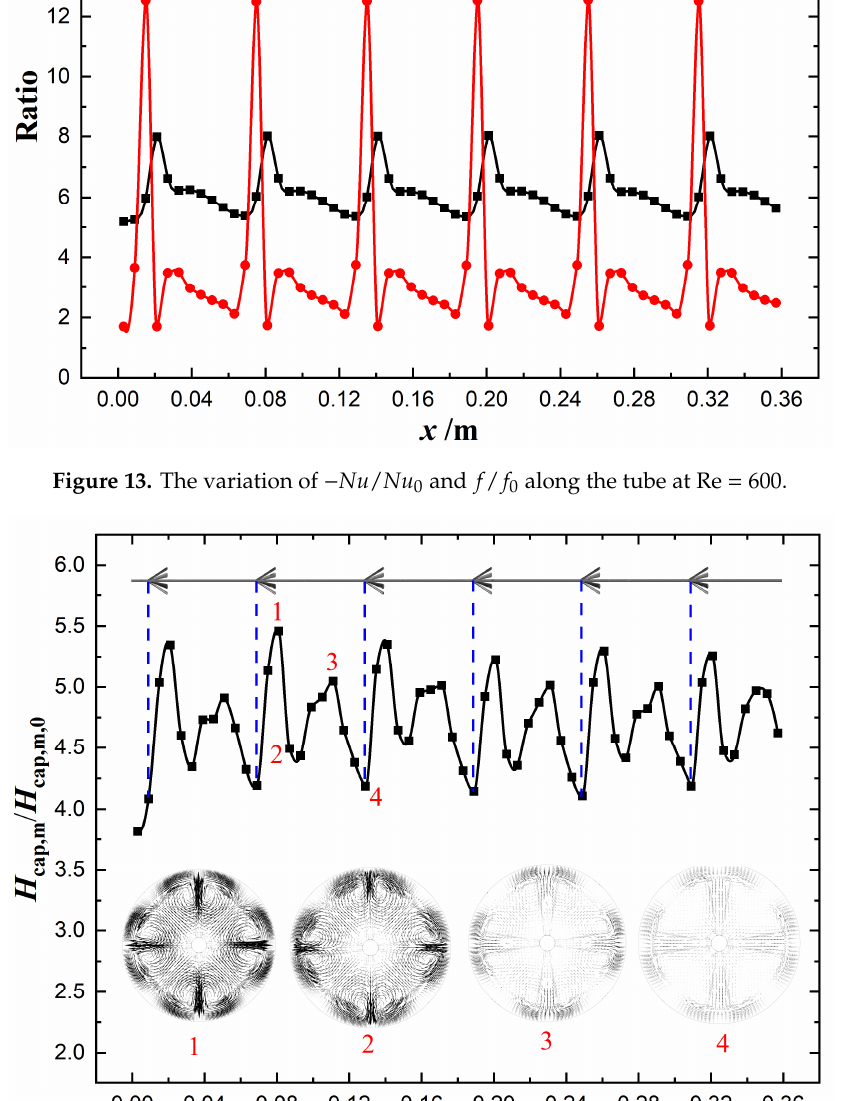
Figure 14. The variation of H cap,m / H cap,m,0 along the tube at Re = 600.